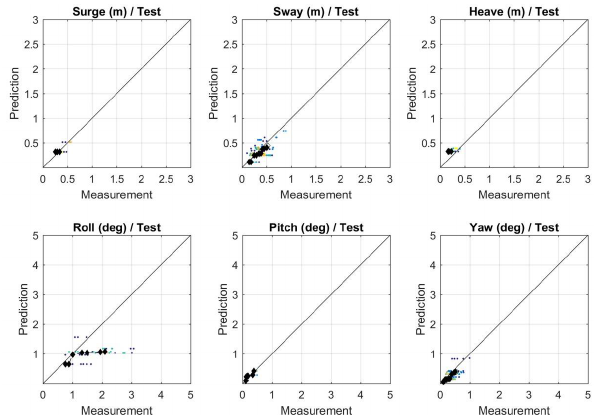
Figure 4. Scatter plots of comparison between the semi-supervised ML-based model predictions and measured data for the six DoF. Joint probability density represented by the color scale. Quantile values equally spaced between 1% and 99.999%, in Gumbel probability paper (-ln(-ln(F)): where F is the non-exceedance probability), are represented by diamond symbols (color-filled symbols for values between 1% and 90%, and by non-filled symbols for values between 90% and 99.999%). Train- ing phase.